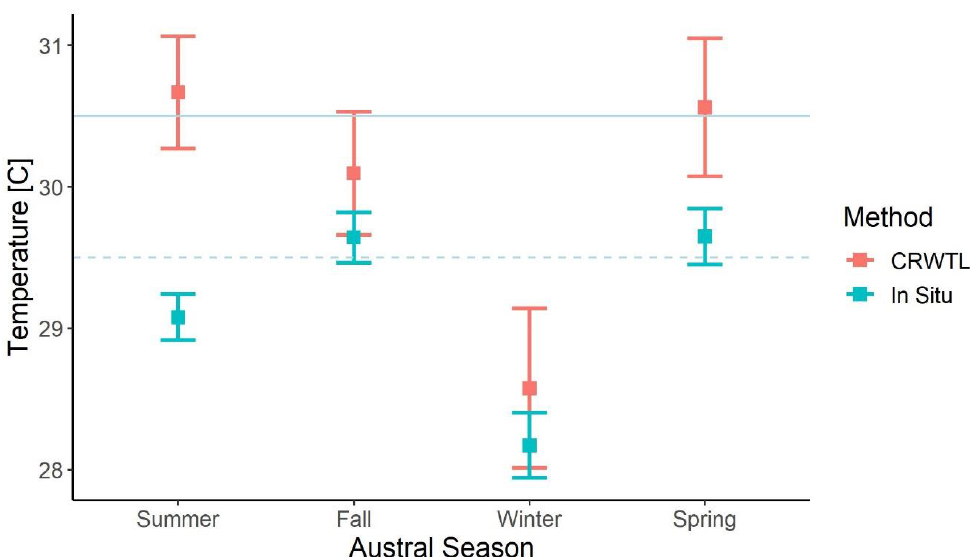
Figure 8. Plot of the significant season × method interaction between the Coral Reef Watch Timor- Leste virtual station (CRWTL) remotely sensed sea surface temperature and in situ temperature logger data collected between November 2015 and July 2017. Divergence in temperature data between the two methods was greatest during the austral summer. The dashed blue line indicates the maximum monthly mean (MMM, 29.5 °C) and the solid blue line is MMM + 1 °C (30.5 °C), the bleaching threshold for the accumulation of degree heating weeks. CRWTL was above the MMM + 1 °C in both the austral summer and spring seasons while the in situ temperature remained below this threshold. Error bars represent 95% confidence intervals.